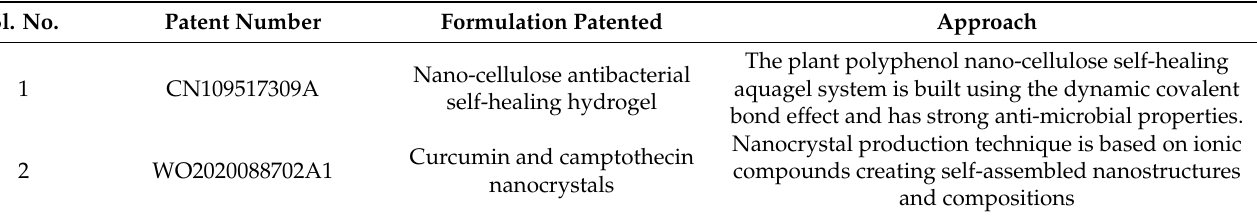
Table 3. Patents of dietary polyphenols in nano-sized drug delivery systems. Sl.